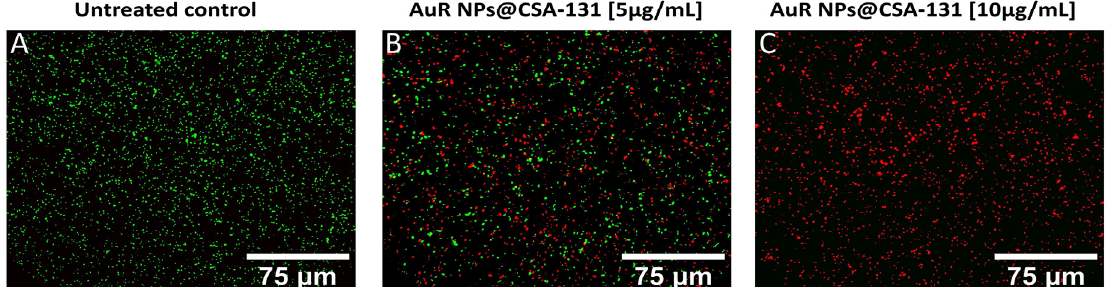
Figure 6. Reduced survival and increase of PI-positive cells upon exposure of the representative strain of Pseudomonas aeruginosa 510 to AuR NP@CSA-131 for 1 h was evaluated using a fluorescence microscope. Panel ( A ) demonstrates the untreated control. On the other hand, the viability of the bacteria cells subjected to treatment with AuR NP@CSA-131 at doses of 5 µg/mL (panel B ) and 10 µg/mL (panel C ) was compromised. The results from one representative experiment are shown.